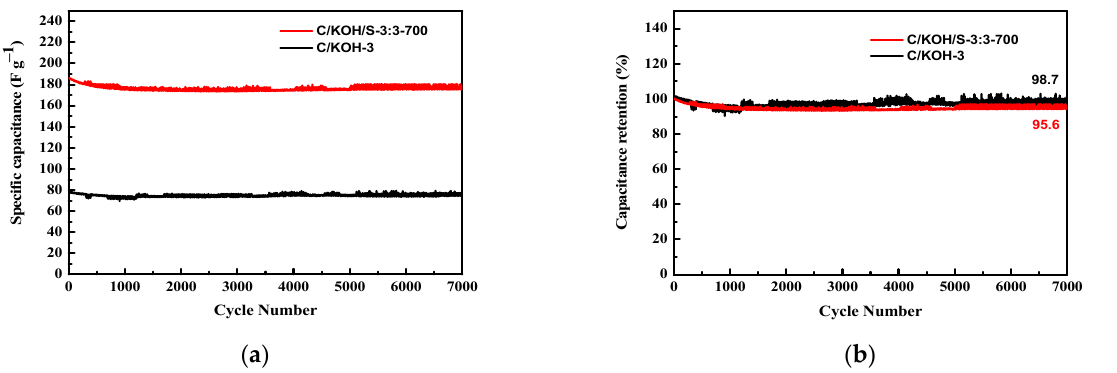
Figure 9. Stability test of C/KOH-3 and C/KOH/S-3:3-700 electrodes ( a ), capacitance retention of electrodes ( b ).